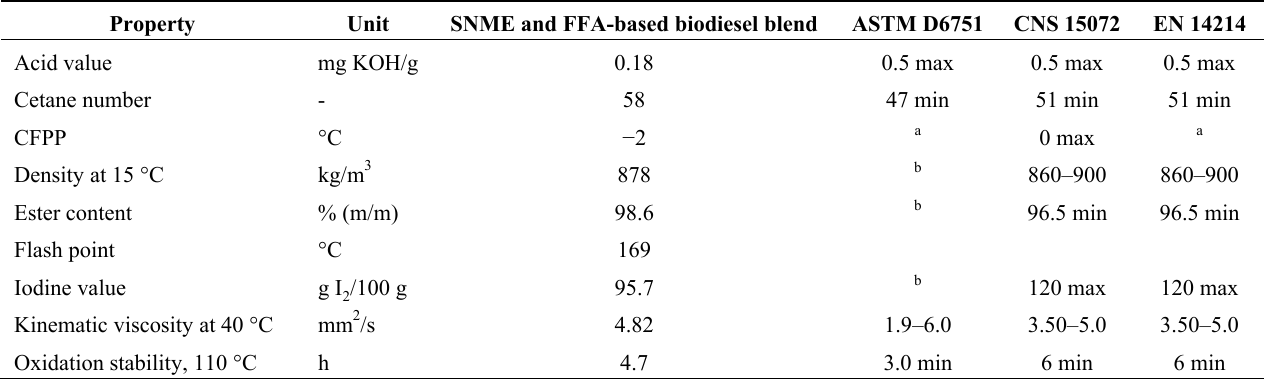
Table 2. Properties of SNME and FFA-based biodiesel blend compared with ASTM D6751, CNS 15,072, and EN 14,214